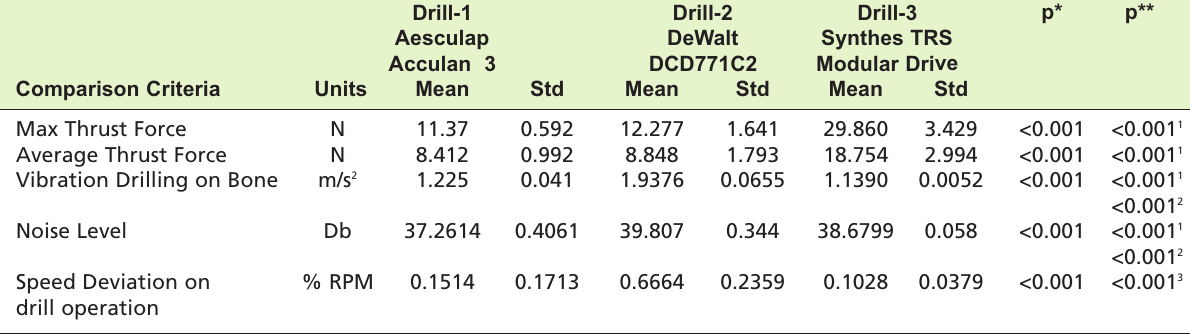
Thrust Force, Vibration, Noise Level and speed deviation characteristic Table III: